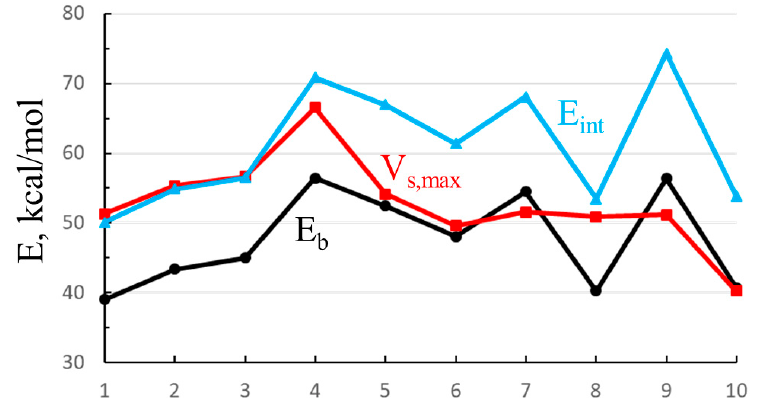
Figure 9. Binding (E b ) and interaction (E int ) energies of complexes of Cl − with each of the monomers (numbering in Table 8), along with maximum in electrostatic potential opposite the F atom of SnFH 2 group. 322